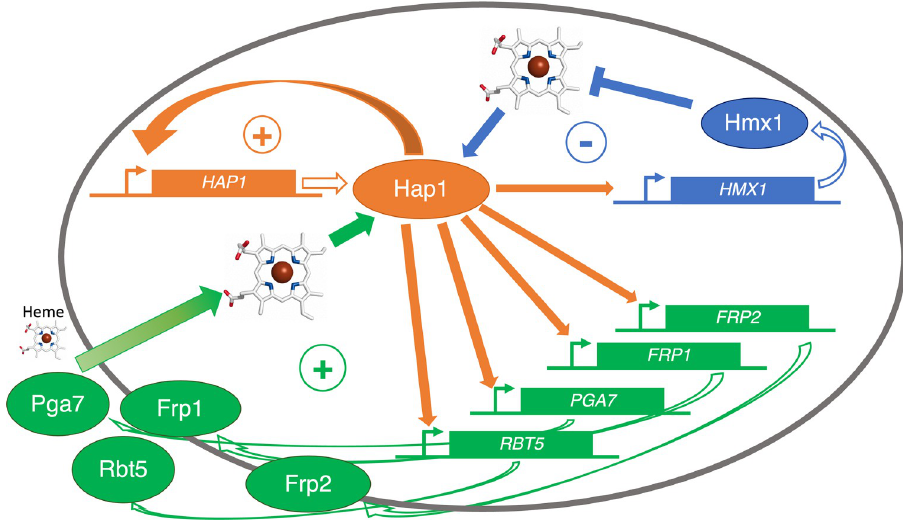
Fig 8. Schematic model for the regulation of heme uptake and homeostasis by Hap1. The genes are depicted as rectangles and the gene products as ovals. The heme degradation function of Hmx1 is depicted in blue and the heme uptake function of the CFEM hemophore pathway is depicted in green. The + and - symbols indicate positive feedback loops and negative homeostatic feedback loops, respectively.